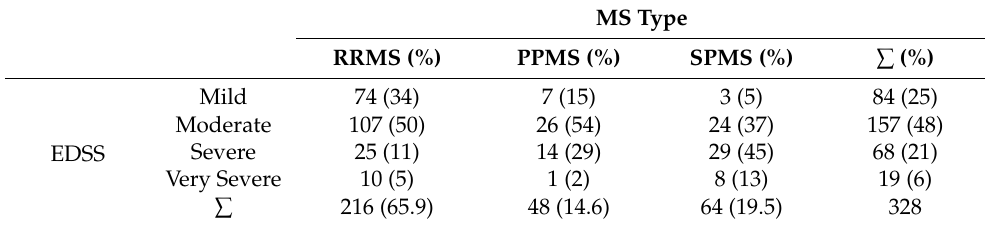
Table 1. EDSS degrees and MS types of the participants.